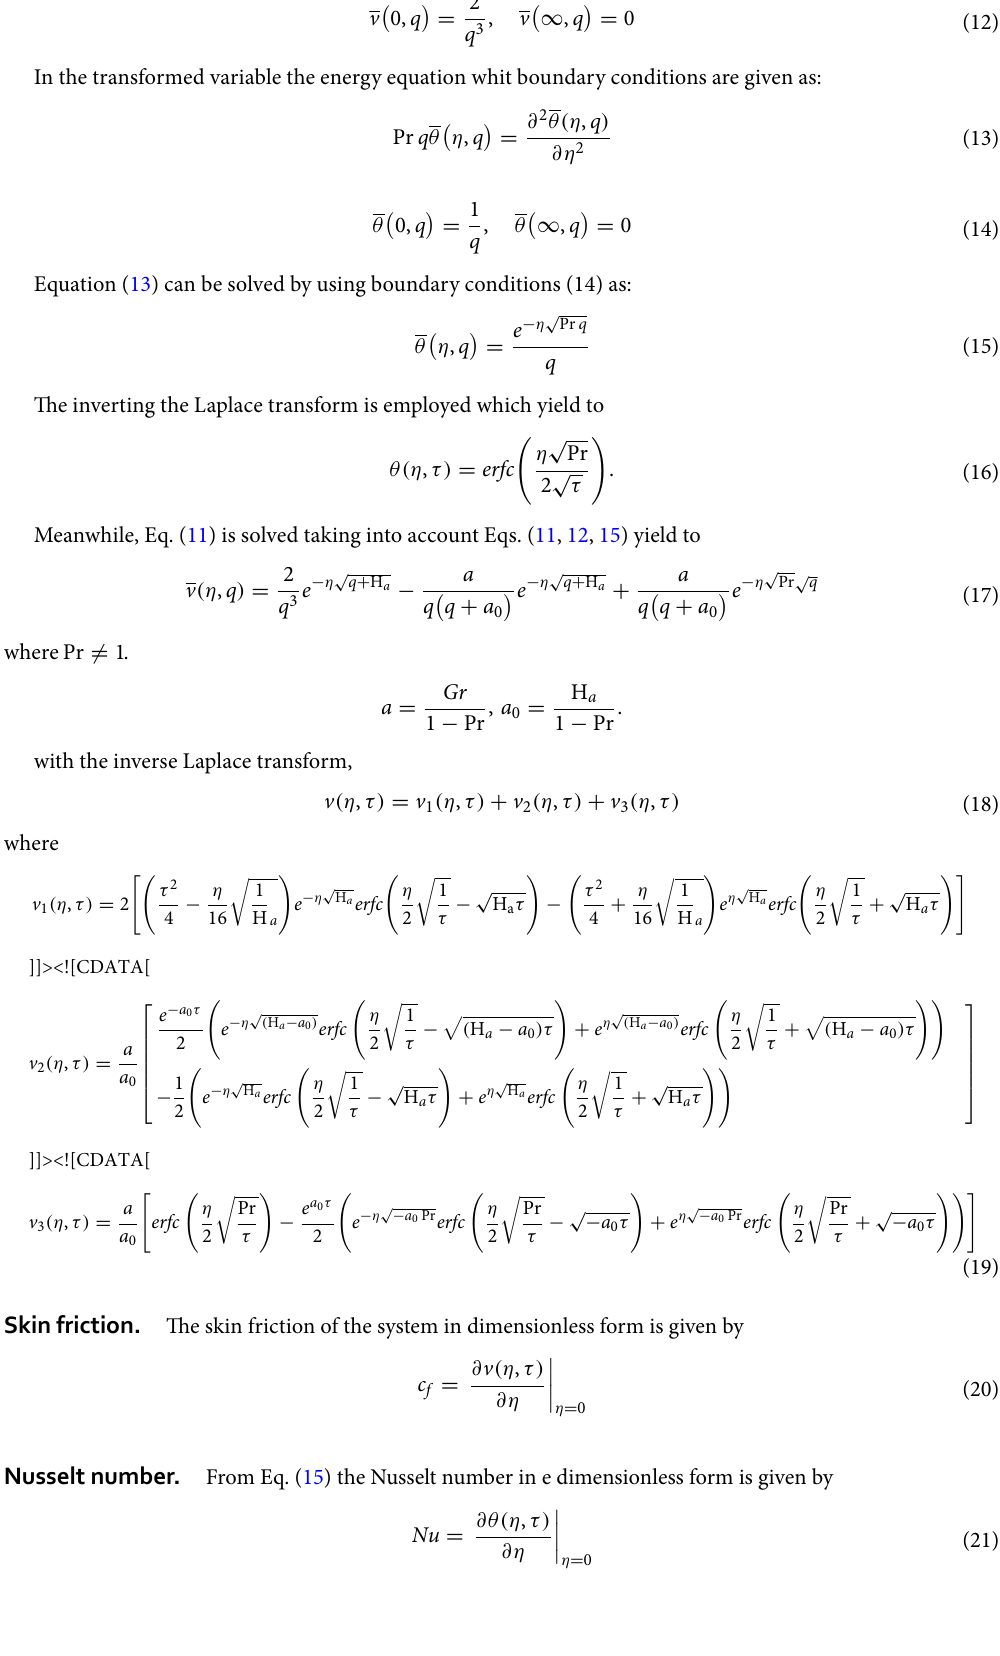
The inverting the Laplace transform is employed which yield to